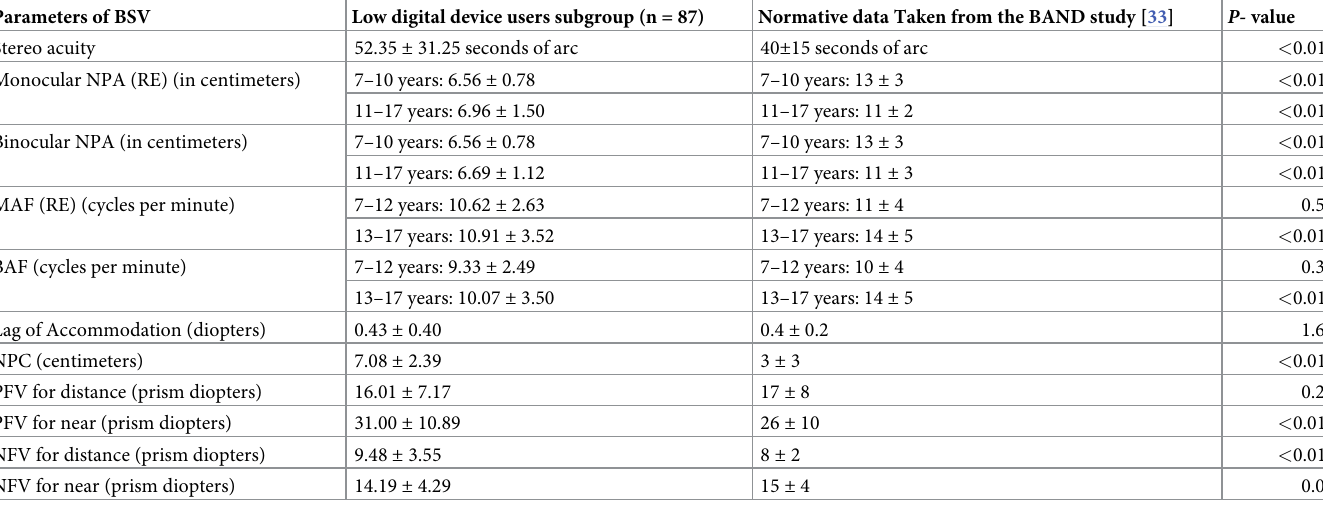
Table 2. Comparison of binocular vision findings of low digital device users subgroup with the normative data taken from the BAND study. Parameters of